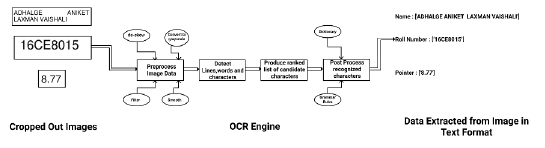
Figure 4. Working of